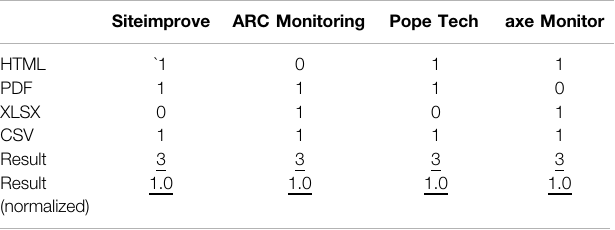
TABLE 8 | Output Formats results. 25